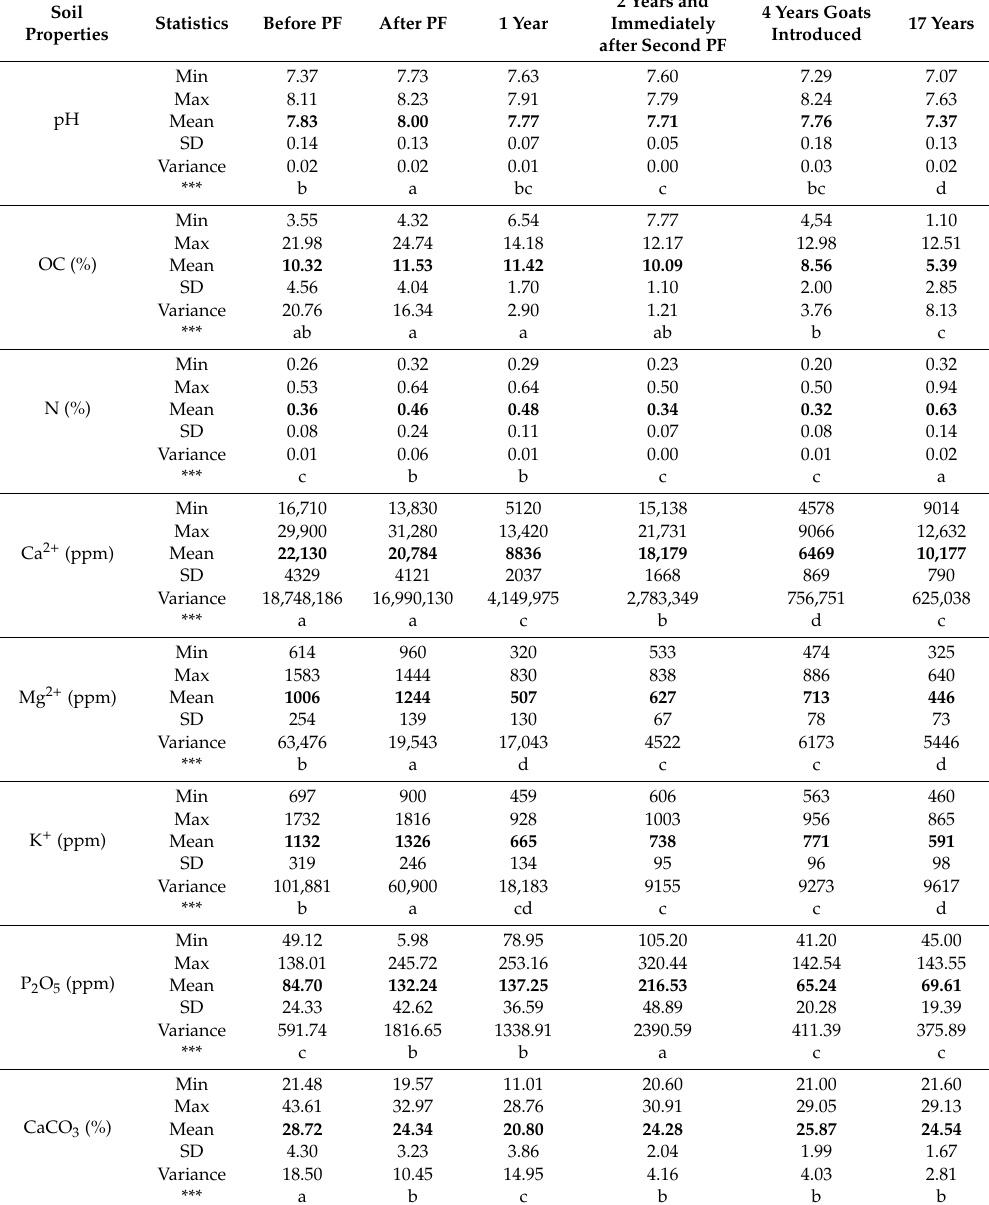
Table 1. Minimum, maximum, mean (in bold), Prescribed Fire (PF), standard deviation (SD), variance, and standard error (SE) values before the prescribed fire (BPF), after the prescribed fire (APF), one year after the prescribed fire (1YAPF), two years after the prescribed fire (2YAPF), four years after the prescribed fire (4YAPF), and 17 years after the prescribed fire (17YAPF). Di ff erent letters